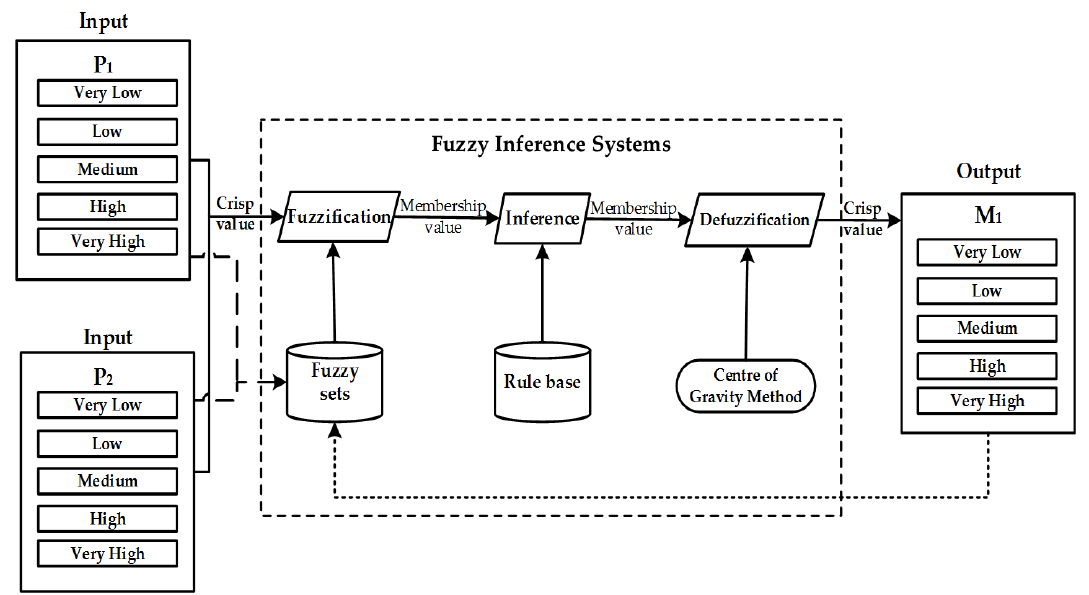
Figure 3. Conventional fuzzy logic (CFL) model.